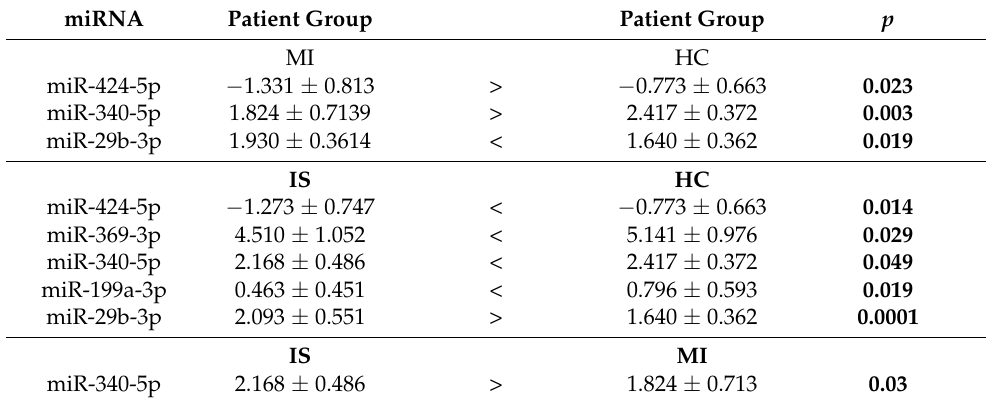
Table 5. MiRNA validation. miRNA Patient Group